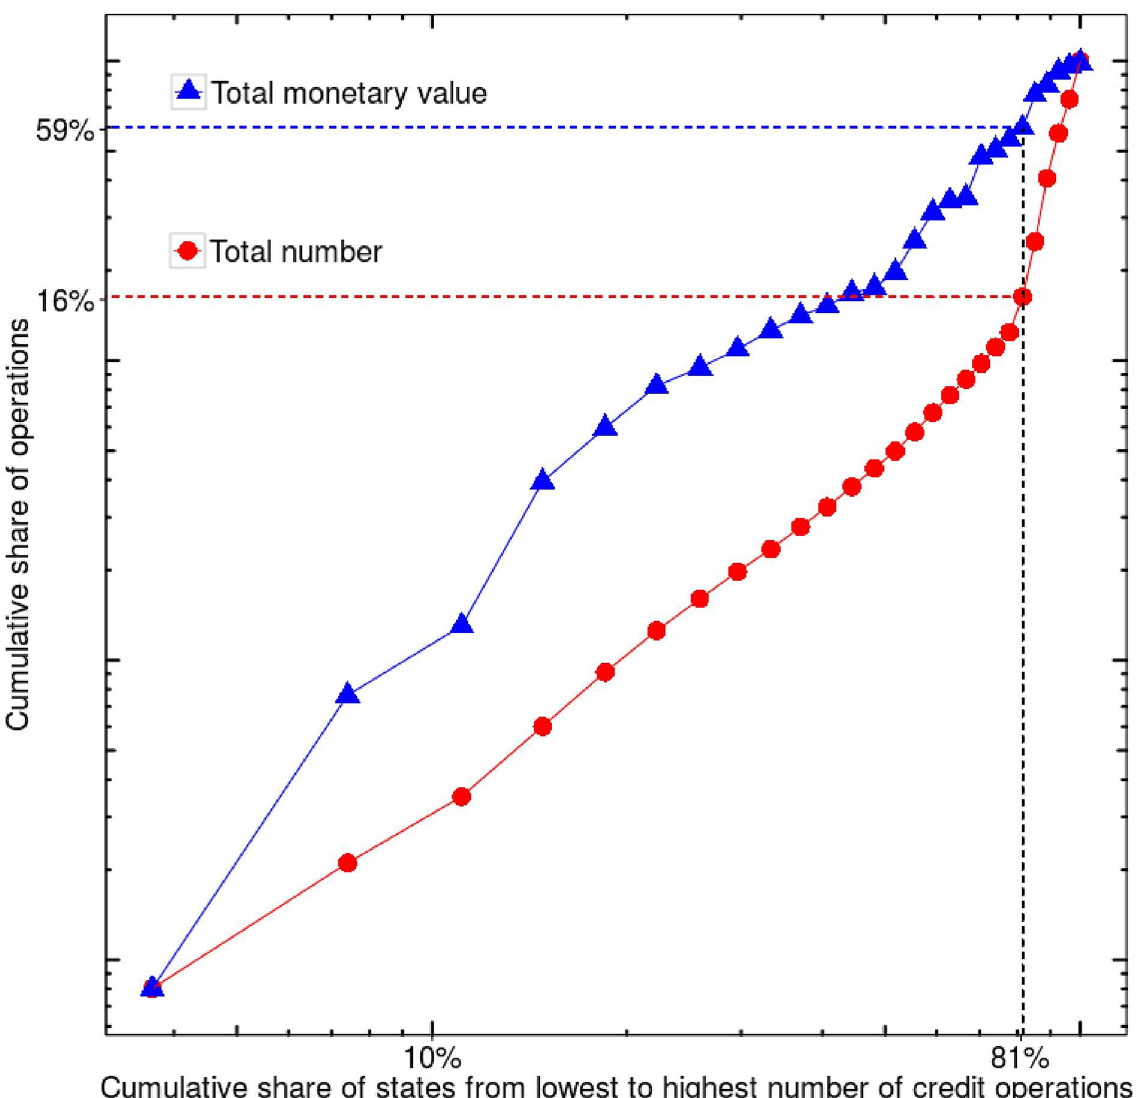
Fig 1. Evidence of heterogeneity in credit operations per federated unit. Most of the volume and monetary value in credit operationsare generatedby a small portion of the federated units in Brazil. 81% of the Brazilianstates were responsible for only 16% of the total number of credit operationsbetween2002 and 2015. The same share of states accountedfor only 59% of the monetary volume in the same